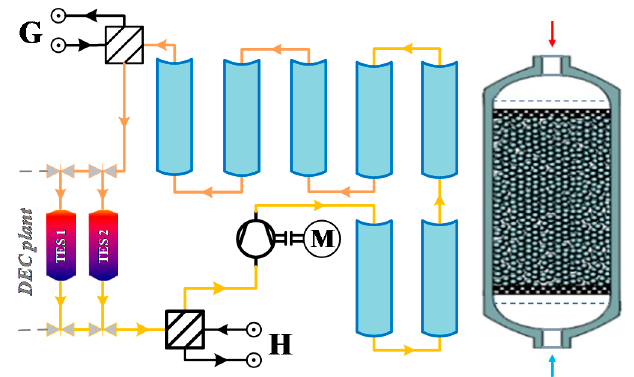
Figure 2. Thermal energy storage layout and tank fluxes representation.